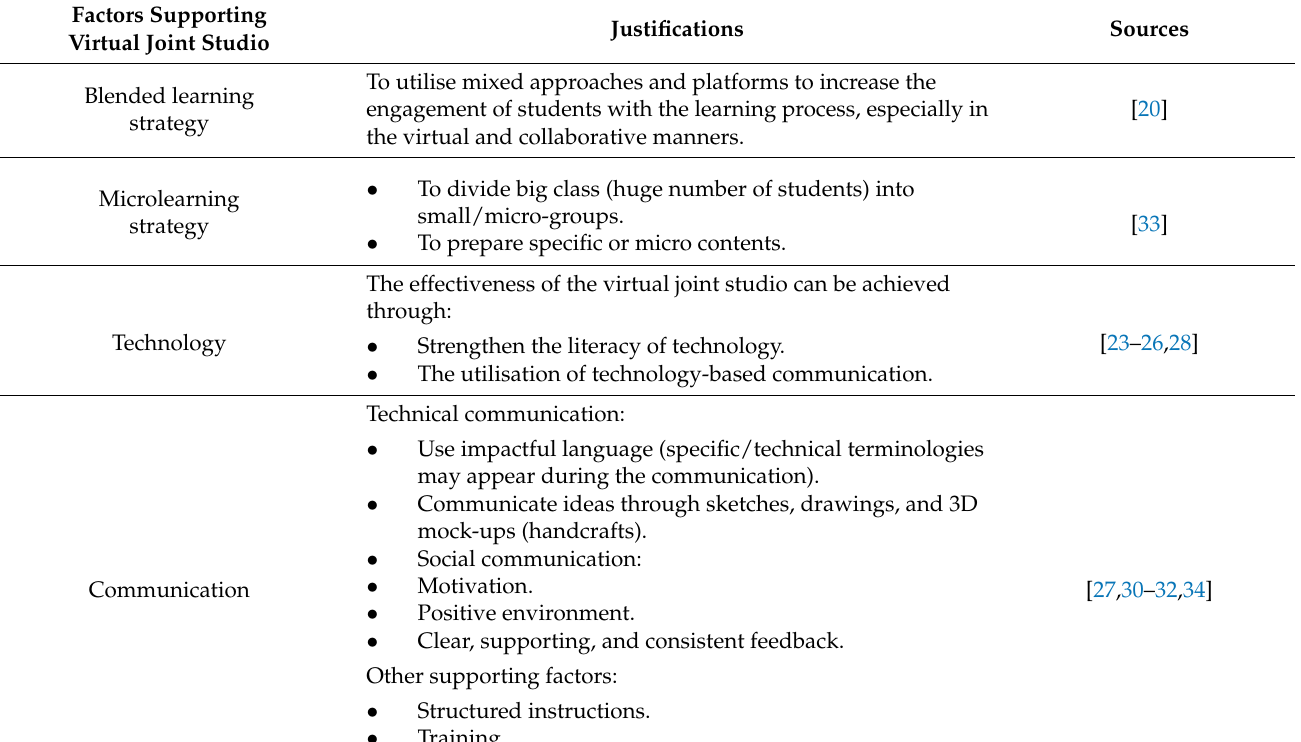
Table 2. Factors supporting virtual joint